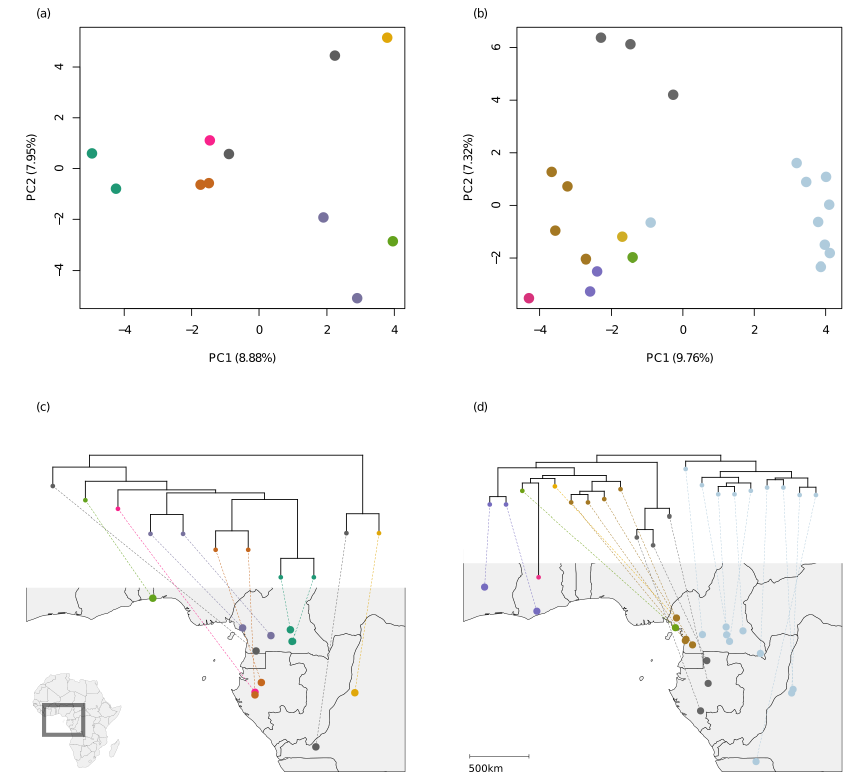
Figure 3. ( a ) scatterplot of R. hookeri complex based on 915 SNPs; ( b ) scatterplot of R. zamiana complex based on 1627 SNPs. Clades representing the ( c ) R. hookeri and ( d ) R. zamiana complexes were extracted from the ASTRAL (Figure 1) tree and linked to their locations on a map of central Africa (area in context on inset map). Individuals are colored by the colors corresponding to SODA species delimitation, an approach that uses gene tree topologies to determine whether coalescence is random or non-random and delimit species based on this. We depict SODA results for two different values of α (confidence): 0.01 in ( a , c ) and 0.005 in ( b , d ). An individual belonging to R. taedigera (RA_TA) is not shown in panels ( a ) and ( c ) due to missing